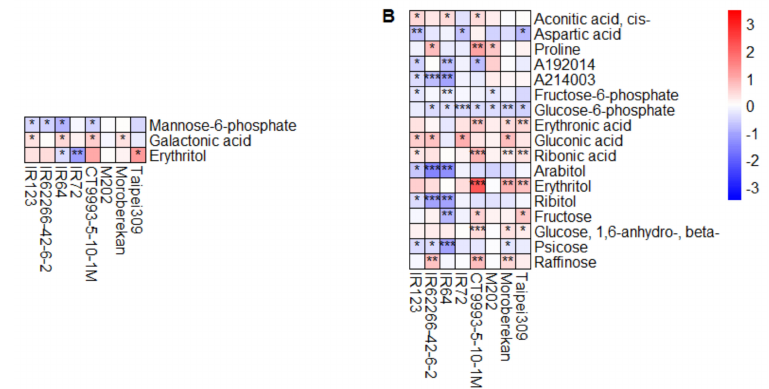
Figure 6. Heat maps showing the log 2 fold changes in metabolite pool sizes in flag leaves under HNT compared to control conditions for the WS ( A ) and DS ( B ). Only metabolites with a significant change in at least three out of the eight cultivars are displayed. The level of significance is indicated by asterisks (* p < 0.05; ** p < 0.01; *** p < 0.001), and the log 2 fold change is represented by the indicated color code. Blue indicates a lower metabolite level under HNT compared to under control conditions, and red, a higher level. Cultivars were sorted alphabetically within the respective O. sativa subspecies indica (1–4) and japonica (5–8).